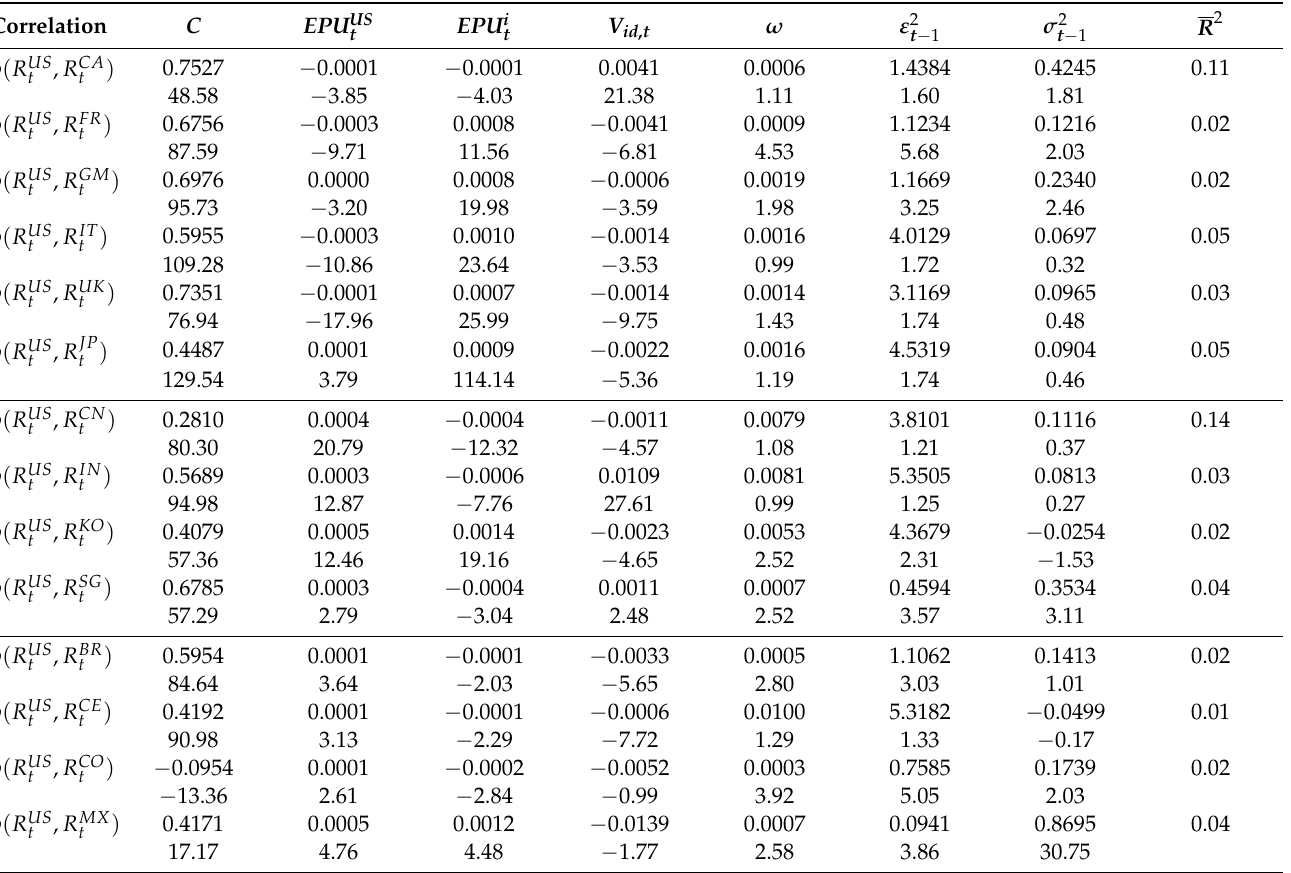
Table 11. Estimates of global–U.S. stock return correlations in response to economic uncertainties including time period of high COVID-19